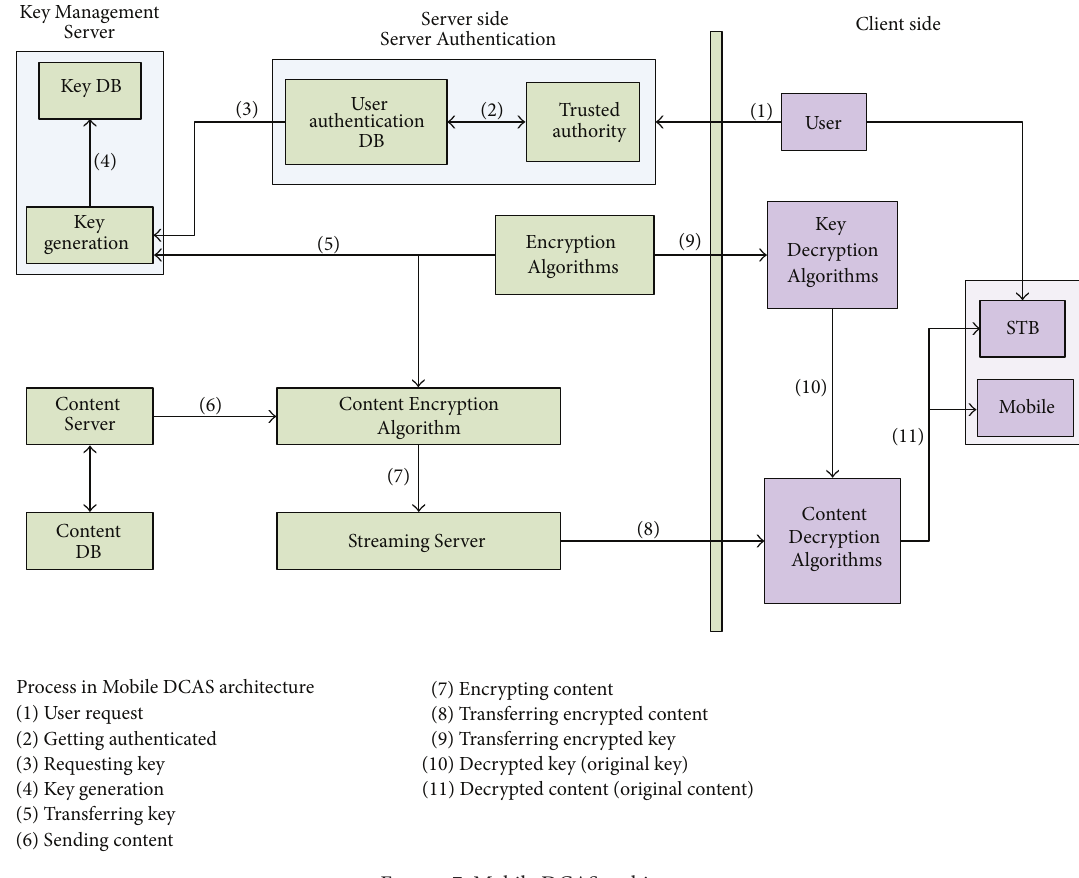
Figure 7: Mobile DCAS architecture.